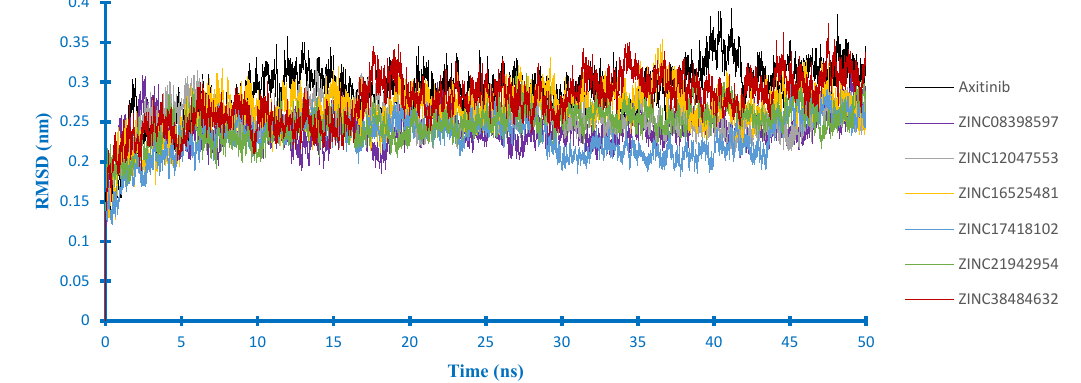
Figure 6. Backbone RMSD of the VEGFR2 complexes.